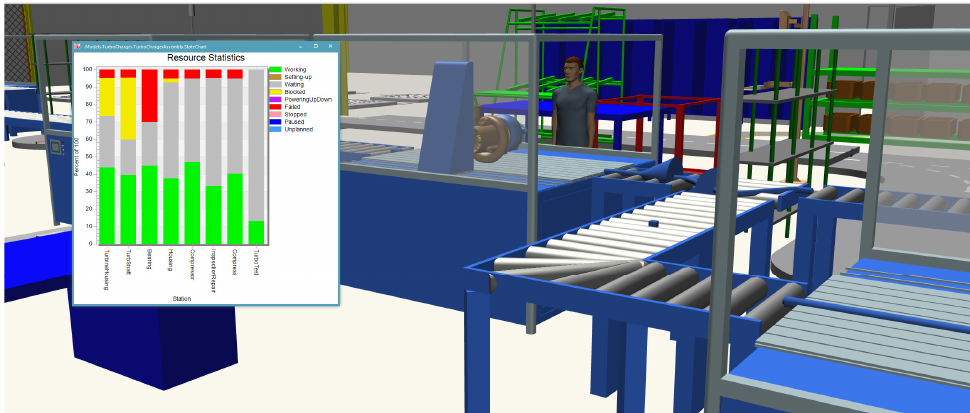
Figure 15. Detail of view from direct position shows in virtual reality